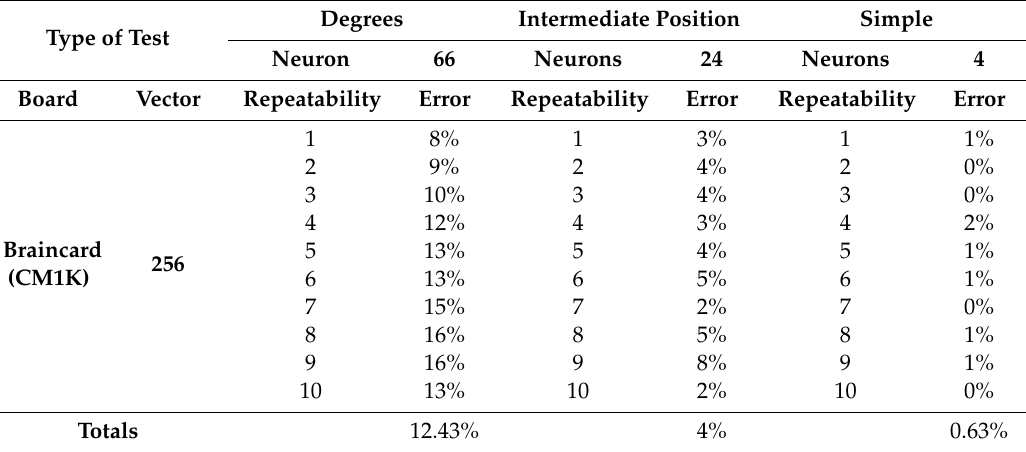
Table 4. Results of the training patterns using a resolution of 1 6 × 16 pixels.